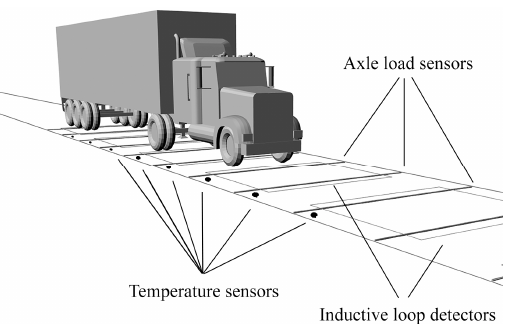
Figure 4. A view of the Multi-Sensor WIM site with temperature sensors installed along the road.